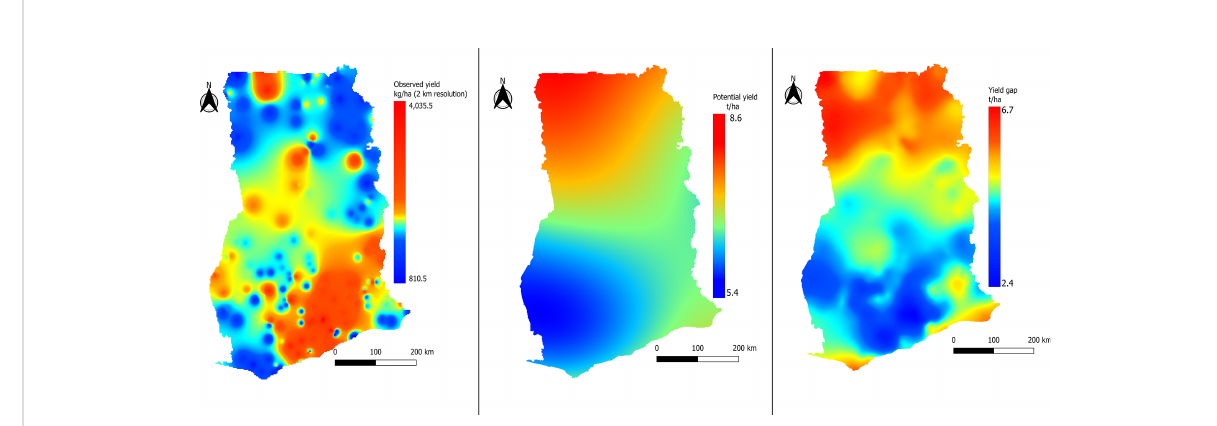
FIGURE 12 Map of observed yield based on inverse distance weighting interpolation (QGIS) at left. And maps of potential yield and yield gap of maize based on ordinary kriging (2,340 points) at